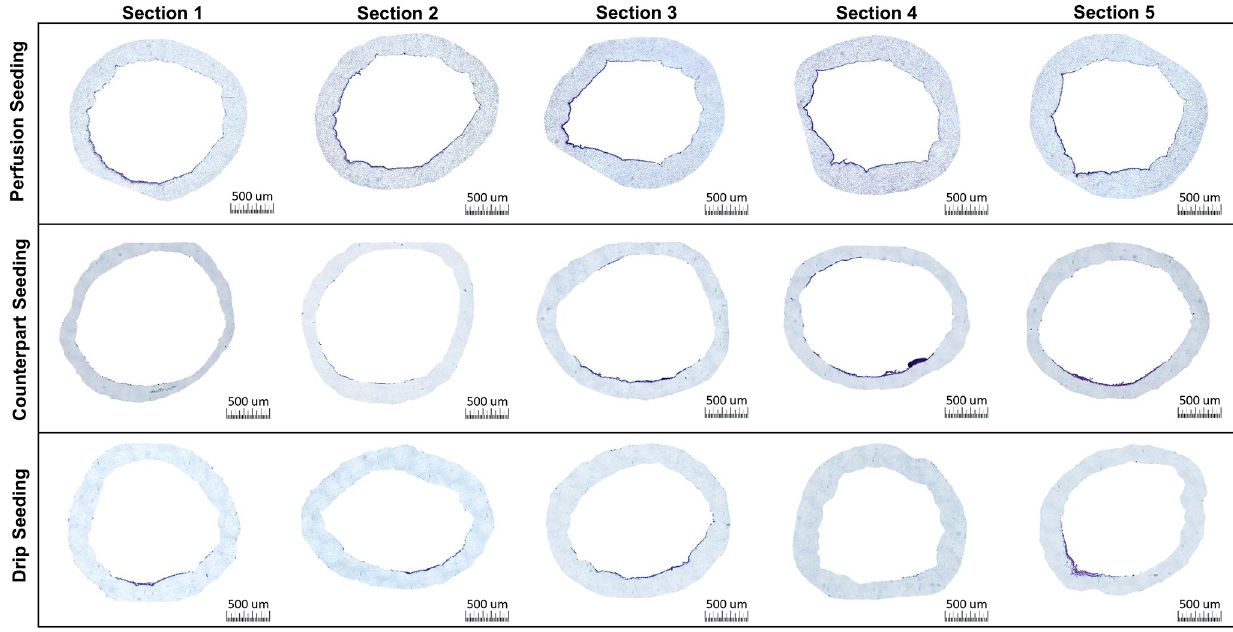
Fig 5. H&E cross-sections. Representative haematoxylin and eosin (H&E) stained cross sections of each seeding method 24 hrs after seeding in longitudinal order.